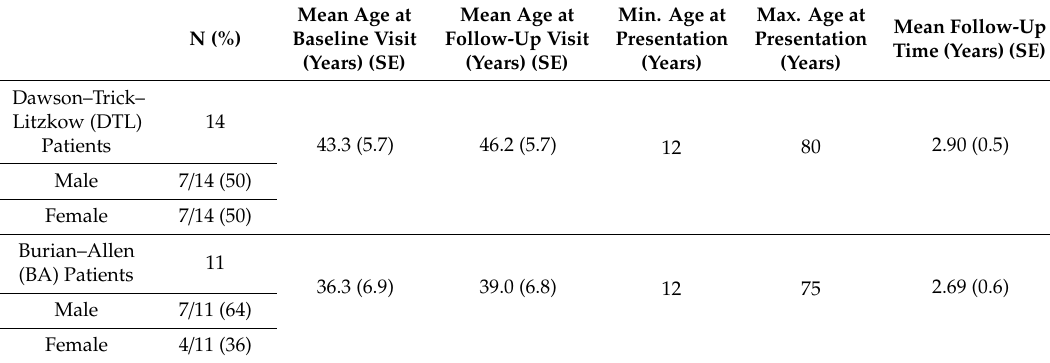
Table 3. Study subjects’ sex, mean age and standard deviation (SE), and follow-up times by